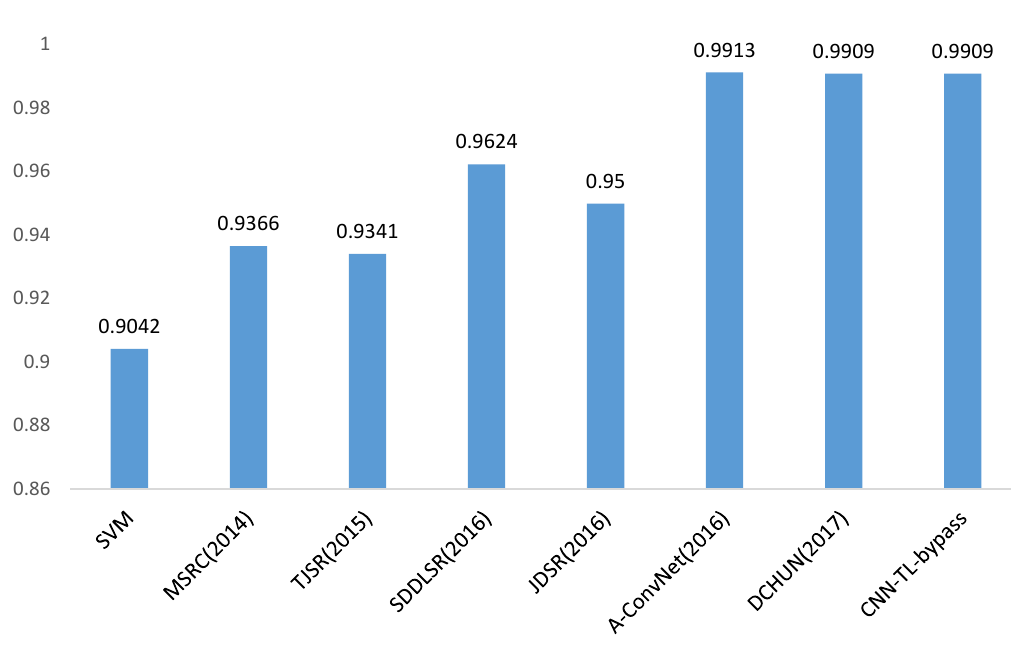
Figure 12. Recognition rate of different methods with full training sets.